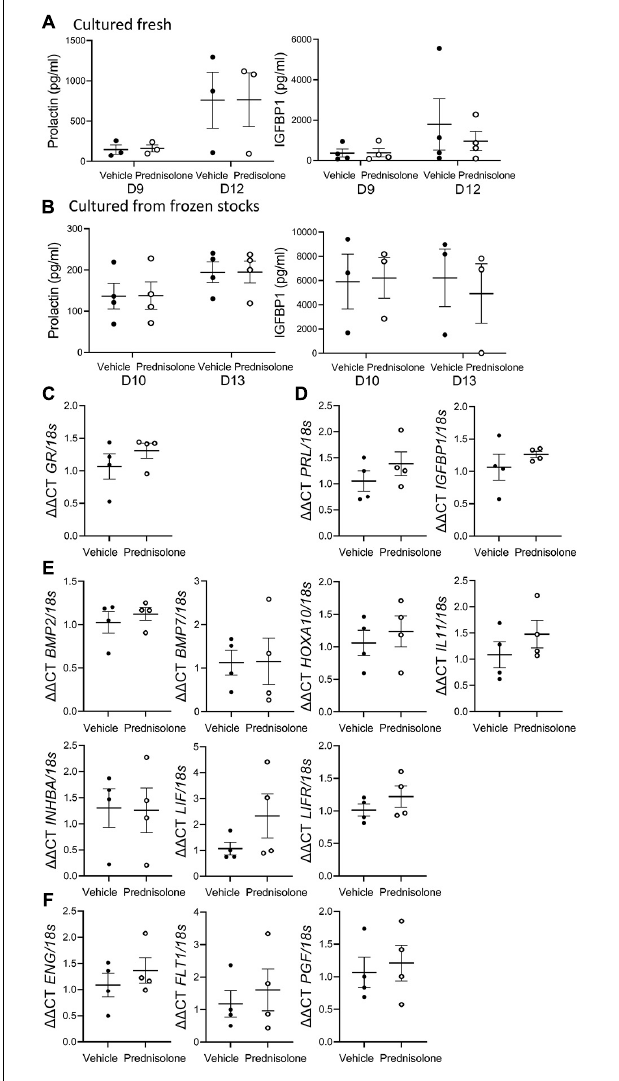
FIGURE 2 | Prednisolone had no effect on classic decidualization marker gene expression or secretion by decidualized human endometrial stromal fibroblast (hESF). Prednisolone treatment: (A,B) had no effect on decidualized hESF secretion of PRL or IGFBP1 from hESF (A) cultured fresh or (B) cultured from frozen stocks, repeated measures ANOVA; n = 3-4/group; (C–F) had no effect on decidualized hESF production of (C) GR ; (D) classic decidualization markers PRL or IGFBP1 ; (E) decidualization genes BMP2, BMP7, HOXA10, IL11, INHBA, LIF or LIFR ; (F) preeclampsia-associated genes endoglin ( ENG), vascular endothelial growth factor receptor (FLT1) or placental-like growth factor (PGF), paired t -test, n = 4/group; Data presented as mean ± SEM; *P <